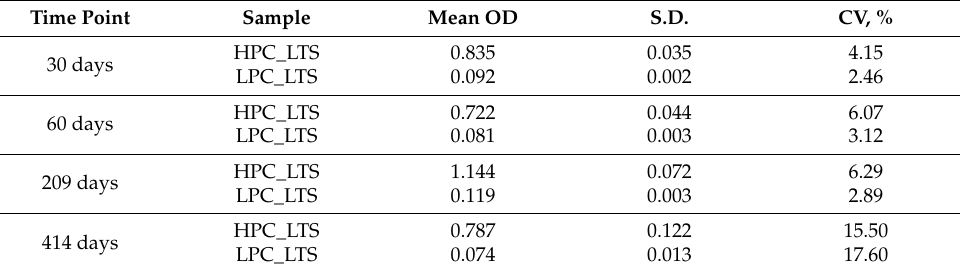
Table 12. CV values calculated for 30-, 60-, 209-, and 414-day long-term stability (LTS)